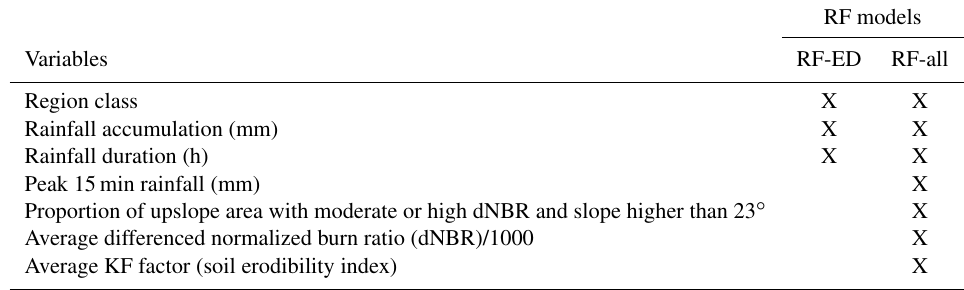
Table 3. Description of variables included in the development of RF models. Symbol X denotes the variables that were included in each model.